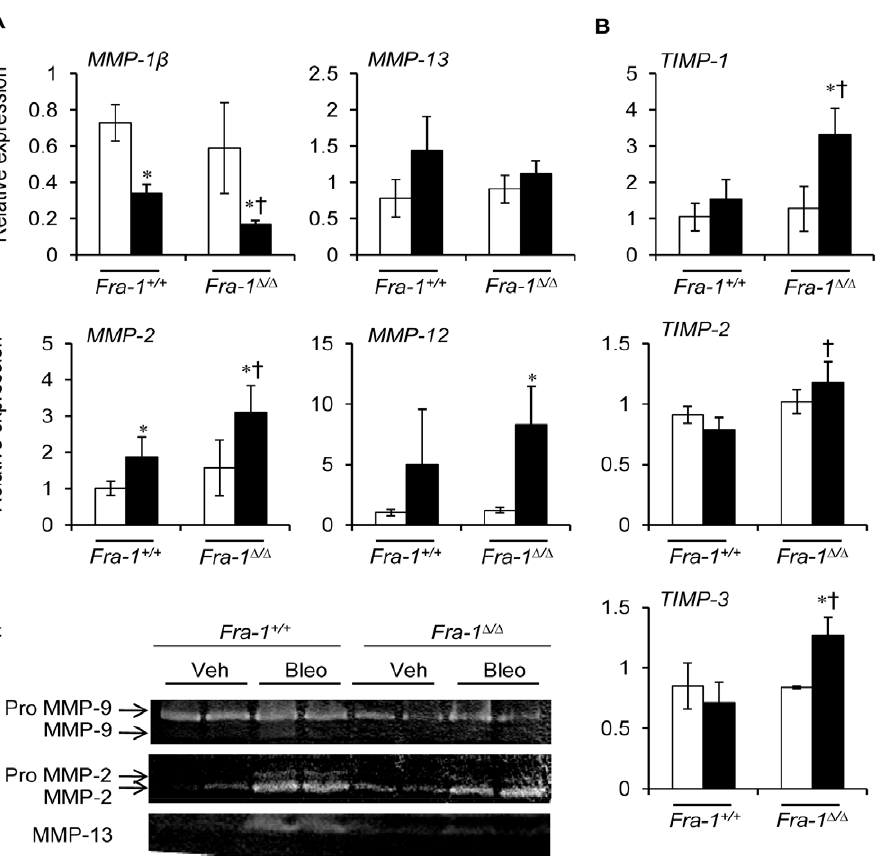
Figure 6. Loss of Fra-1 leads to an altered MMP and TIMP gene expression in the lung. MMP ( A ) and TIMP ( B ) gene expression in the lung tissue at 31 days post-bleomycin administration (n=4 2 6). C: Detection of MMPs activity by collagen zymography in lung tissue 31 days post-